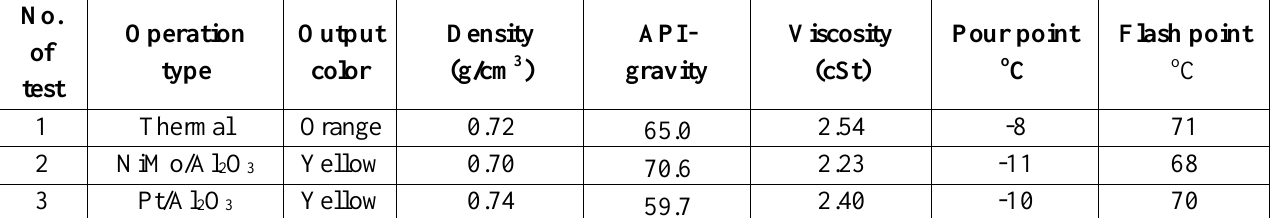
Table 1: Physical properties of liquid product.